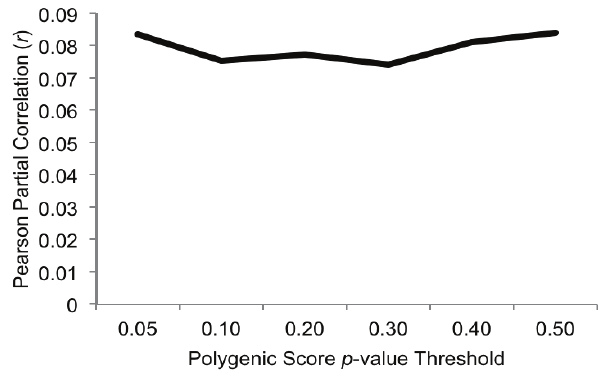
Figure 1. Pearson partial correlations (controlling for sex) between polygenic scores